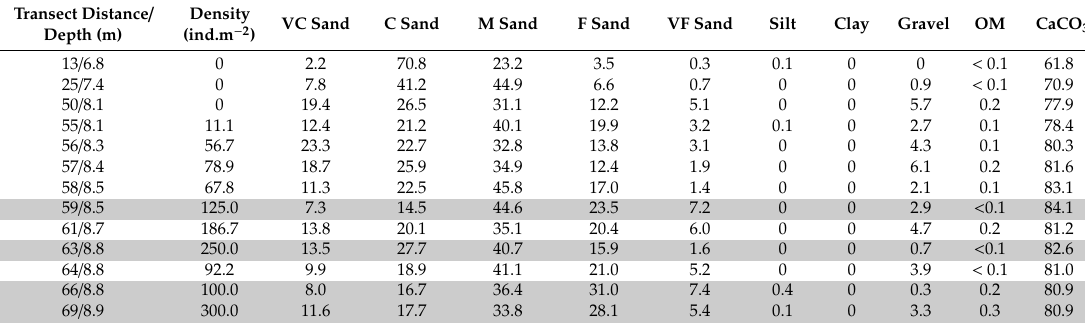
Table A5. U. noronhensis densities and sediment characteristics along the sampled transect in autumn. Sediment data are represented in percentages. Shaded rows represent data collected along with resin casts. Sand classes: VC sand = very coarse sand; C sand = coarse sand; M sand = medium sand; F sand = fine sand; VF sand = very fine